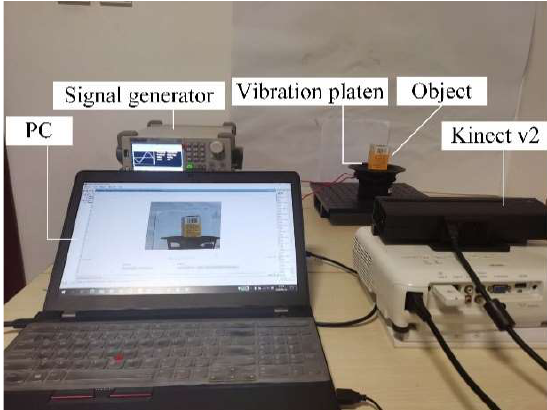
Figure 7. Experimental structure and environment. Sensors 2020 , 20 , x FOR PEER REVIEW